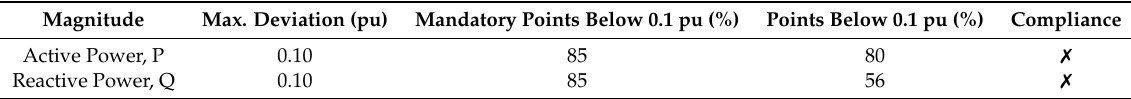
Table 3. Verification of the PVVC validation criteria applied to the IEC generic WT model at the testing point, operating at full load conditions: 20 kV, measurement point